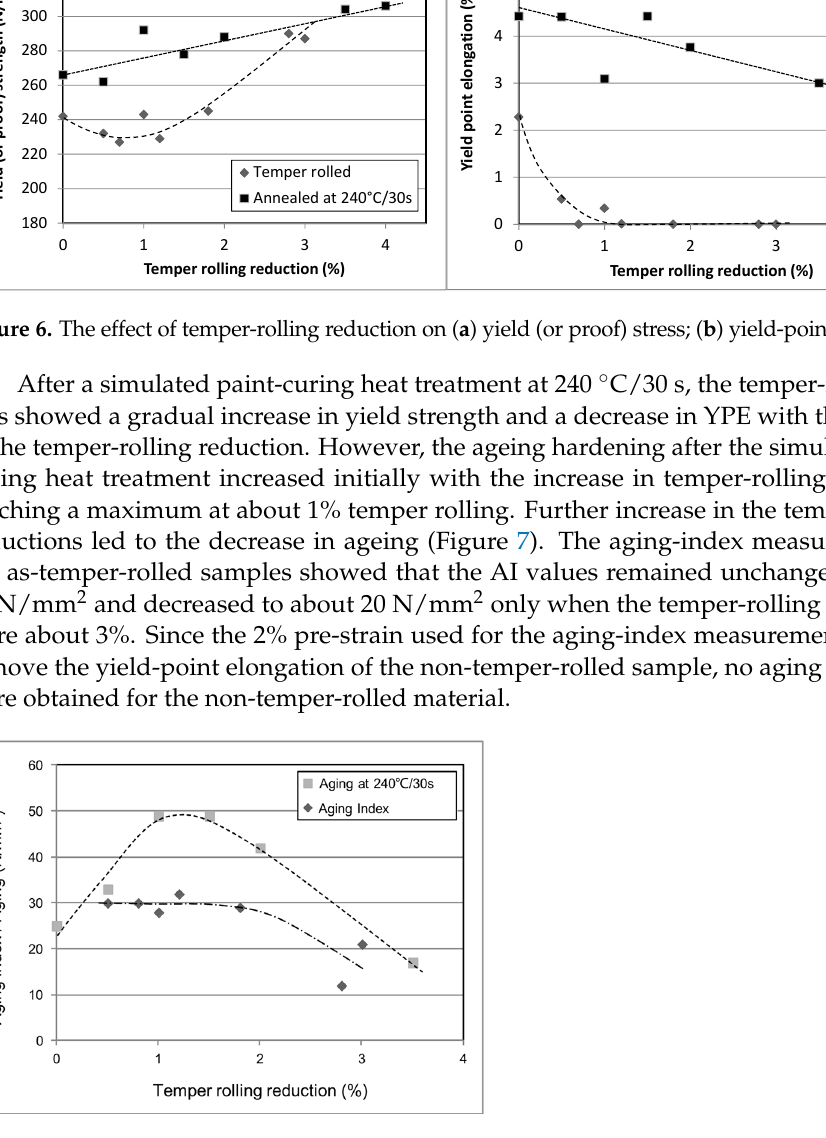
Figure 7. The effect of temper-rolling reduction on ageing and aging index of low-carbon CQ strips.